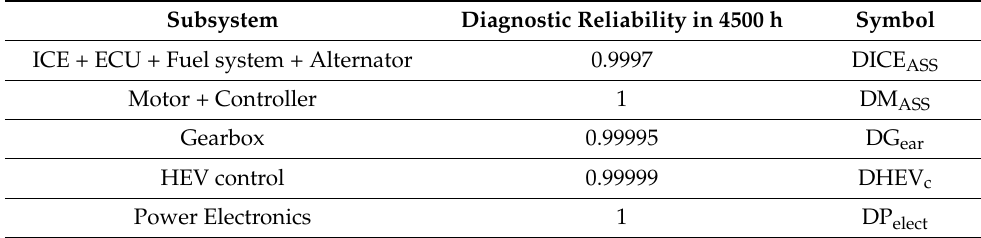
Table 5. Probability of early diagnosis in